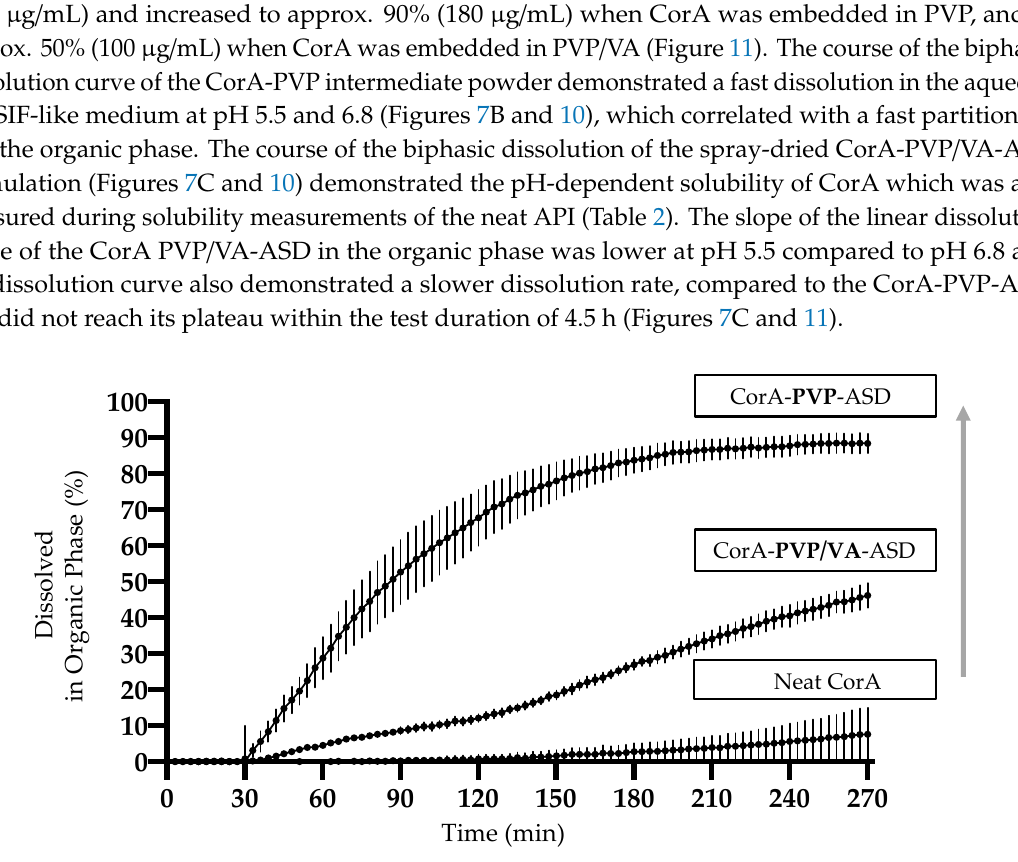
Table 2. PH-dependent solubility, partition coefficient (log P ) and distribution coefficient (log D ) of neat CorA determined by Pion’s T3 apparatus.